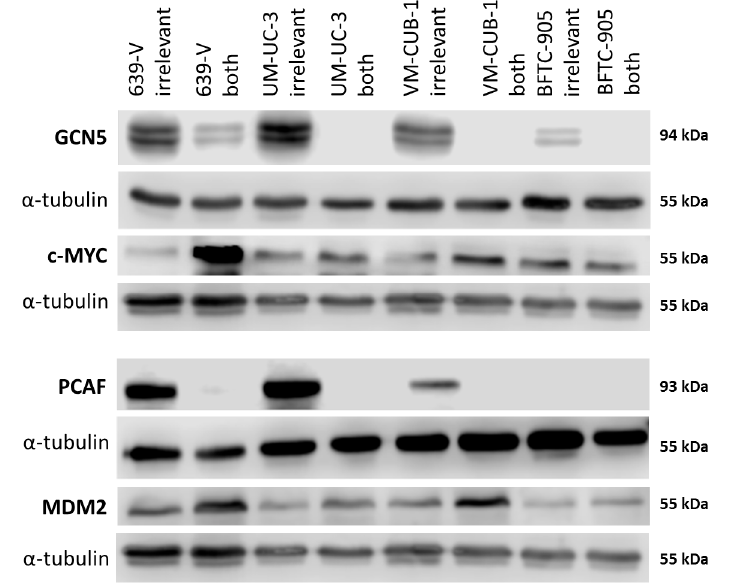
Figure 6. Protein levels of GCN5 and PCAF and potentially interacting proteins in UCCs after combined knockdown. Western blot analysis of PCAF and GCN5 expression in the indicated UC cell lines following treatment with non-targeting (irrelevant) siRNA or with siRNAs against PCAF and GCN5 (both). In addition, their potential interactors MDM2 and c-MYC were analyzed, respectively. α -Tubulin was used as a loading control c-MYC was detected on the same membrane as MDM2 after stripping. α -Tubulin was used as a loading control once for this blot and is shown beneath each of the proteins of interest. A quantification of the signals is illustrated in Figure S4.